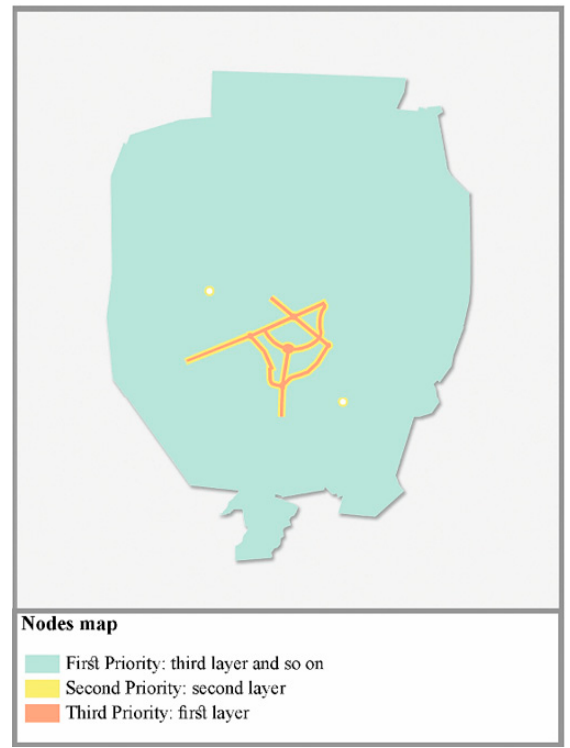
Figure 12. The nodes map of Hamedan based on the sub-criteria measures in Table 1.